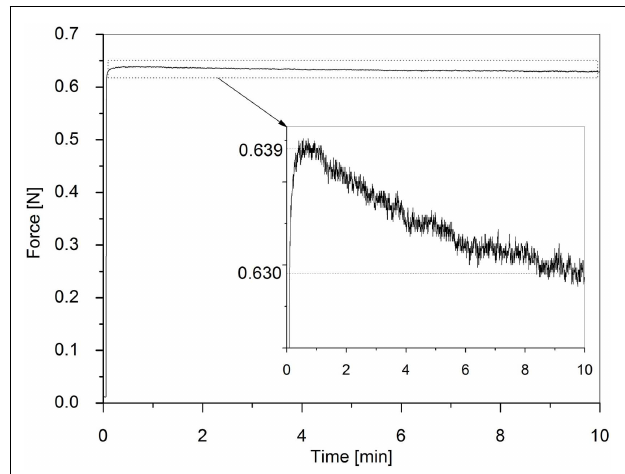
FIGURE 9 | Stress relaxation test over 10min .The inset shows a magnification.